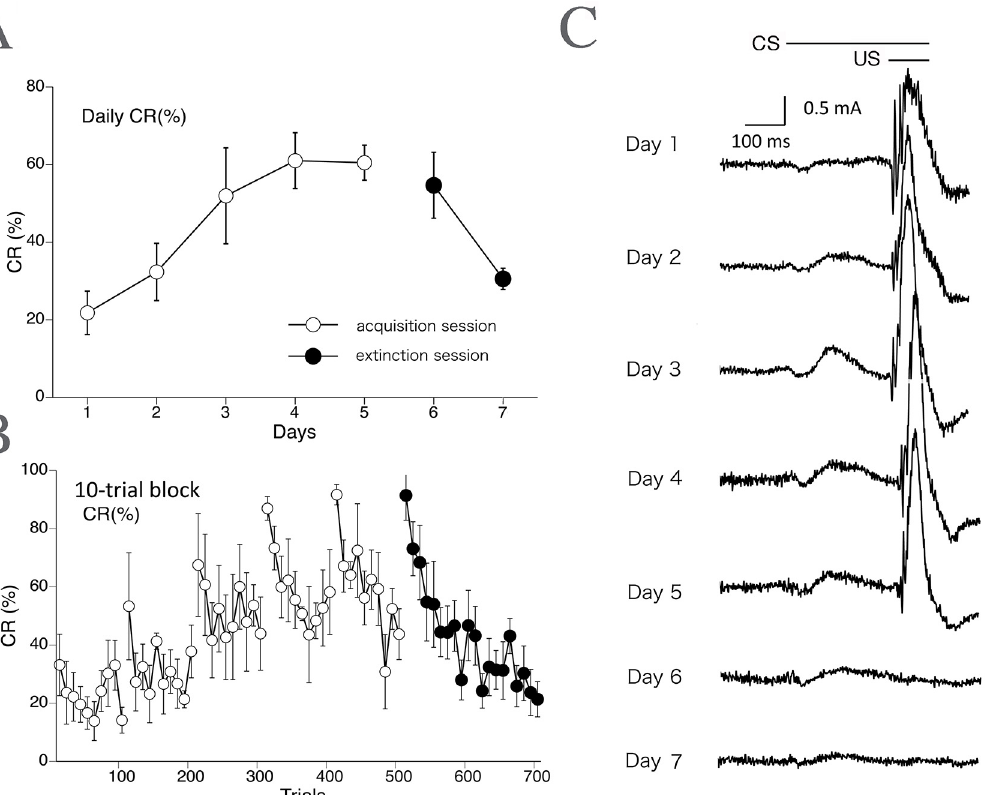
Fig 3. Delay eyeblink CR incidence (%) calculated across trials in monkeys (EMG data). The CR incidence (CR%) for all monkeys ( n = 5) calculated on a daily (A) and 10-trial-block (B) basis, with 10 such blocks being run per day. (C) The rectified and averaged EMG amplitudes from all monkeys on days 1 – 7. In the extinction sessions, presentation of the CS without the US results in loss of the CR.